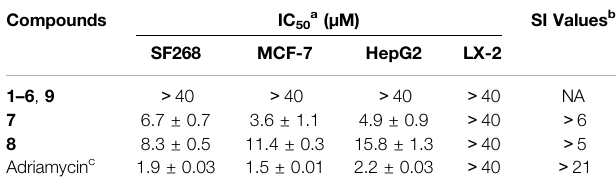
TABLE 3 | Cytotoxicity of compounds 1 – 9 against three human cancer cell lines.